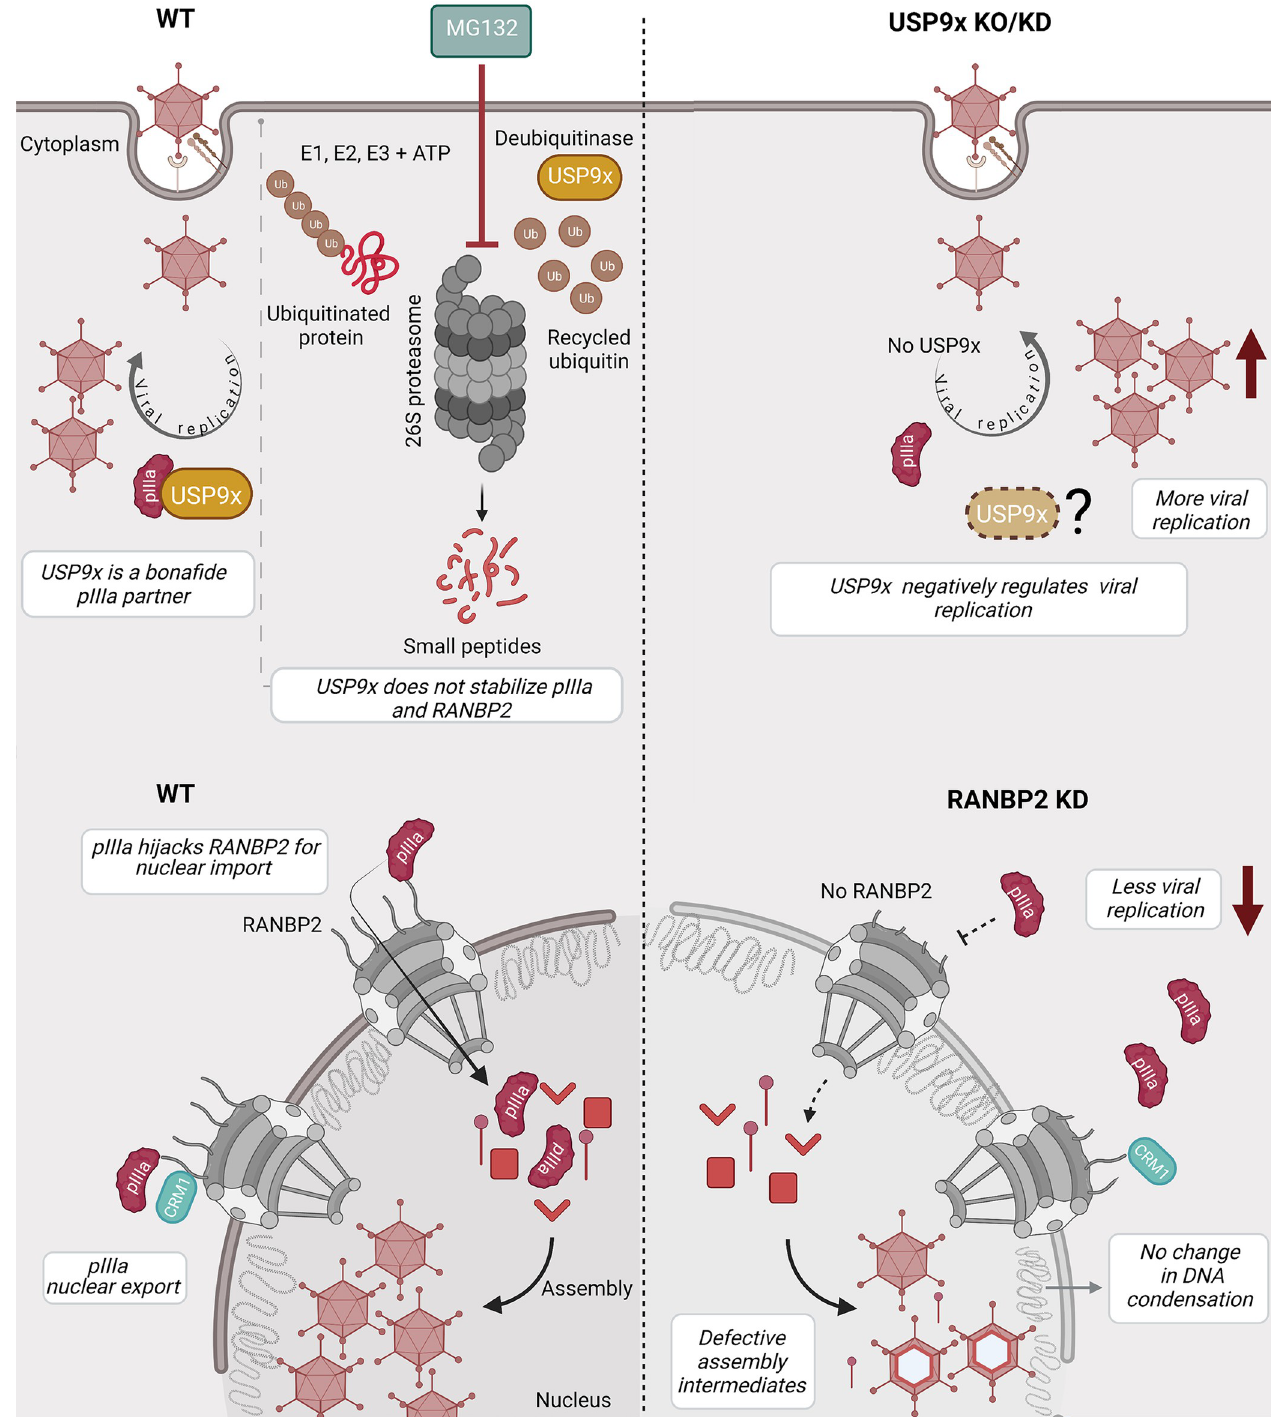
Fig 10. Schematic overview of pIIIa, USP9x, and RANBP2 interactions. During infection, viral pIIIa bound to host USP9x. MG132 proteasome inhibitor treatment did not stabilize pIIIa or RANBP2 steady state concentrations. On the other hand, viral replication increases in USP9x knockout (KO) or knockdown (KD) cells suggesting that USP9x favors the host during infection by negatively regulating viral replication. Viral pIIIa binds to nucleoporin RANBP2, using its nuclear import function for translocation to the nucleus. RANBP2 knockdown does not impact the early stages of infection–there is no change in nuclear DNA entry or nuclear chromatin condensation. However, RANBP2 knockdown reduces viral replication, leading to accumulation of defective assembly products in the infected cells. CRM1 modulates RANBP2-pIIIa interactions and cytoplasmic transport. USP9x and RANBP2 bind to different sites of C-terminus pIIIa. These interactions are important across different HAdV